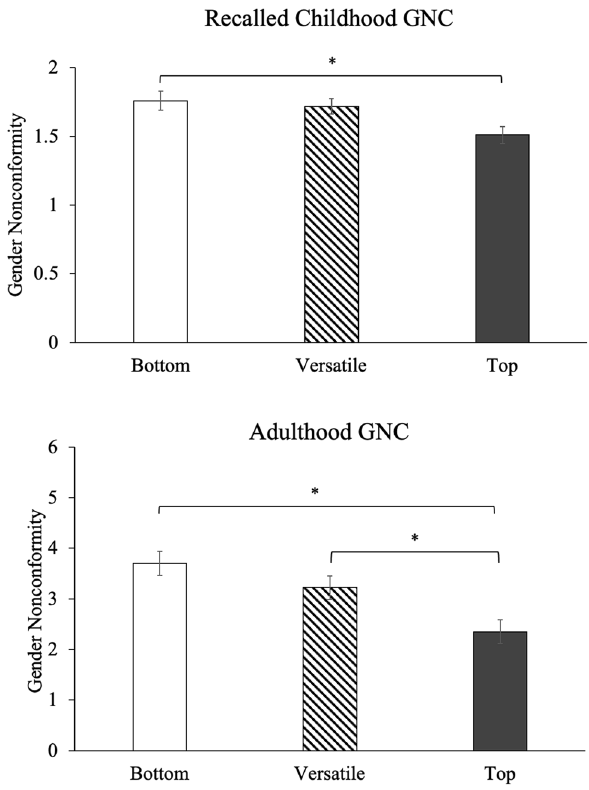
Figure 2. ASR preference groups differ in gender nonconformity. On both Recalled Childhood GNC and Adulthood GNC measures, ASR Tops rated themselves as more male-typical compared to Bottoms. On the Childhood GNC measure, Versatiles were intermediate, such that they did not significantly differ from Tops or Bottoms. On the measure of Adulthood GNC, Versatiles rated themselves as more GNC than Tops. For consistency across measures, score on the Recalled Childhood GNC scale were subtracted by 5 and multiplied by negative 1; Thus, a higher score on both the Childhood and Adulthood GNC indicates more gender non conformity. * Significant difference, p <